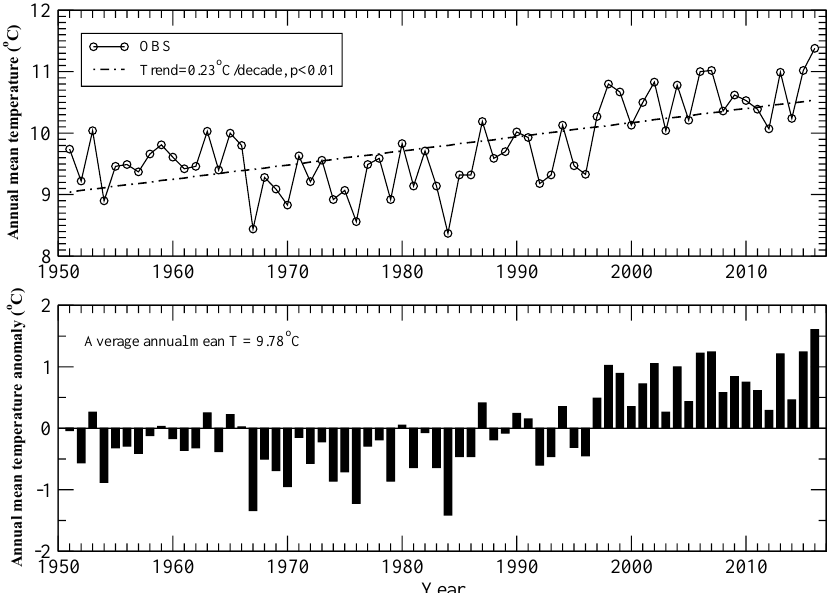
Figure 6. The time series plot of the annual mean temperature and the trend ( top ); the annual mean temperature anomaly plot ( bottom ).